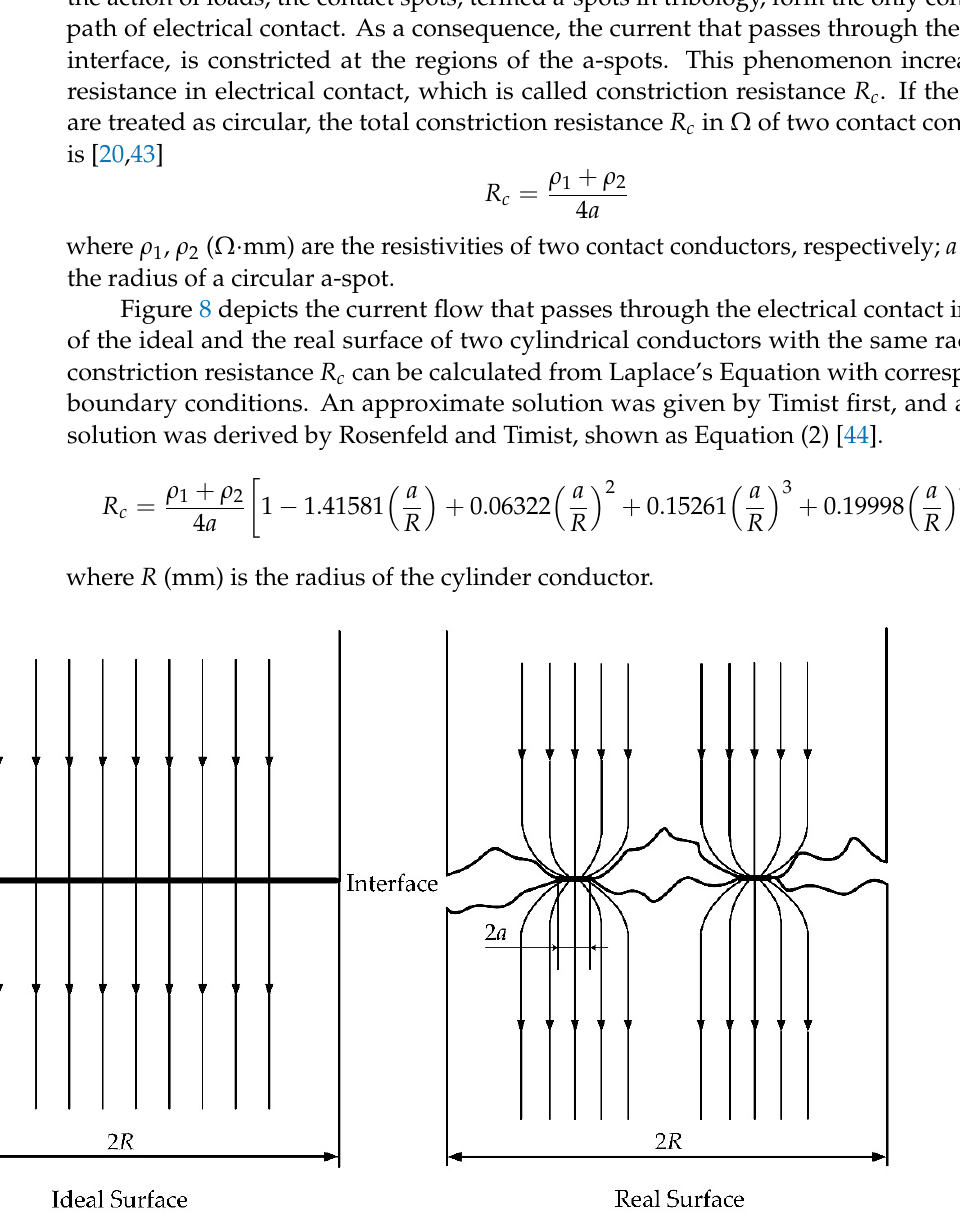
Figure 8. Current flow distribution of electrical contact interfaces.